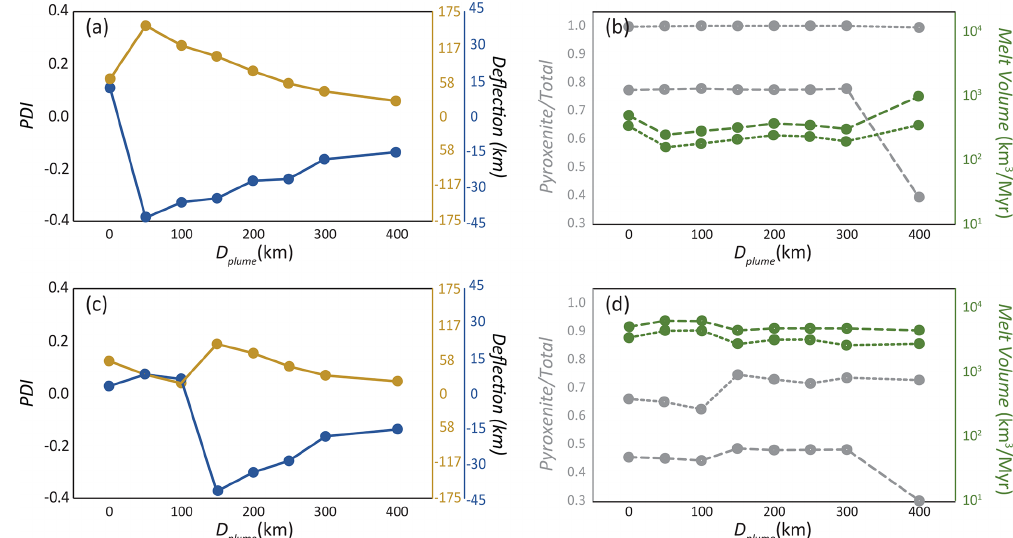
Figure 8. Diagrams showing the sensitivity of key output parameters to D plume . (a, c) PDI stem (light brown) and PDI pancake (blue) in the steady state for models with variable D plume . (b, d) M , V , M PX , and V PX , for models with variable D plume . Panels (a) and (b) : results for M V a relatively weak plume with (cid:49)T plume = 150 ◦ C and B plume = 100kgs − 1 are given. Panels (c) and (d) : results for with a relatively strong plume with (cid:49)T plume = 200 ◦ C and B plume = 200kgs − 1 are given. Legend as in Figs. 4, 6.